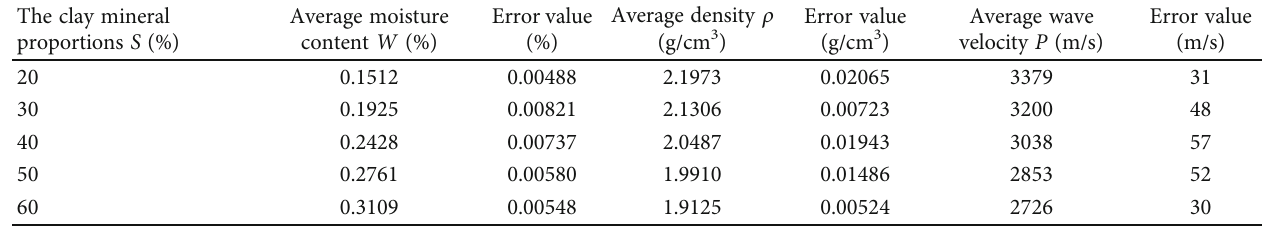
Table 2: Changes of average water content W , density ρ , and wave velocity P with clay mineral proportions S .